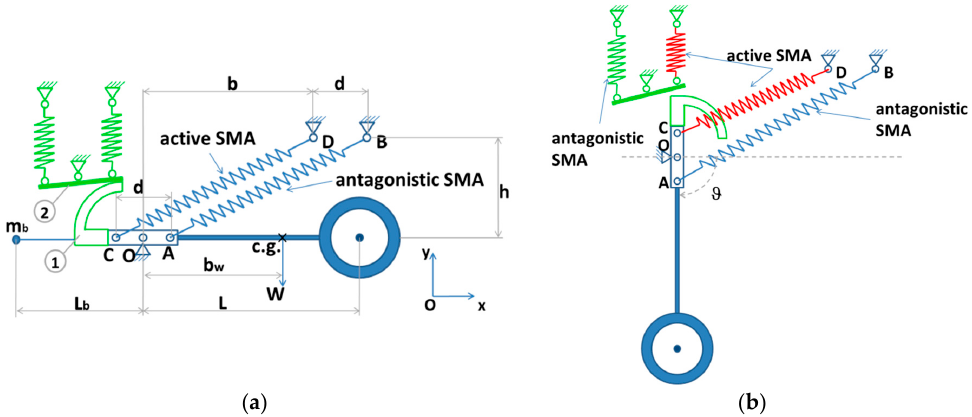
Figure 3. Reference structural schemes: retracted ( a ) and deployed configurations ( b ). Points A–D represent the hinges of the SMA springs used for deploying the arm of the landing gear; O is the pivot of the arm; W is the weight of the arm applied on its center of gravity, c.g.; L and L b represent the distances of the wheel axis and of the additional mass m b from the pivot O; finally the green assembly represents the blocking system.